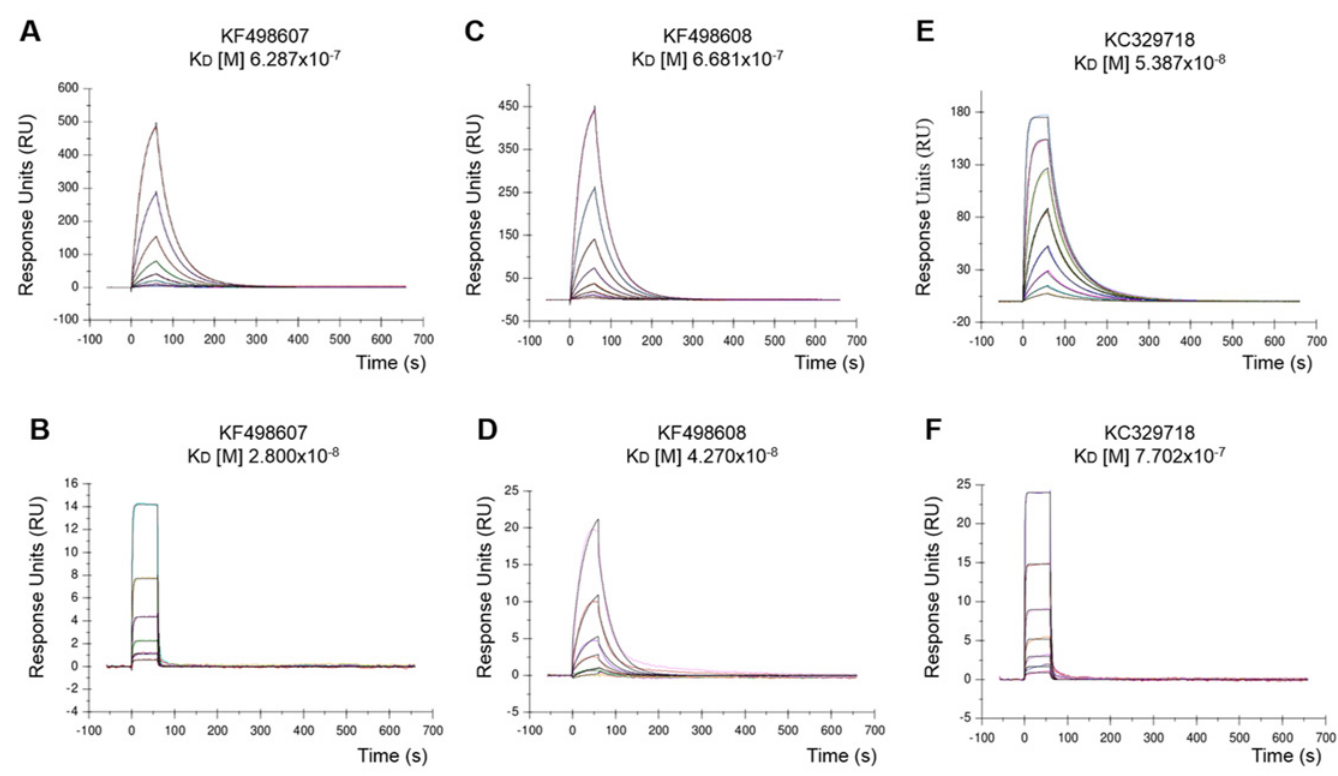
Fig 4. VHHs affinity to BthTX-I and BthTX-II. Representative sensorgrams of the interaction were measured in a Biacore T200 system (GE Healtcare). Purified VHHs (KF498607, KF498608 and KC329718) at concentrations of 6.25 to 0.049 μ g/mL were flowed over a BthTX-I-coated CM5 chip and 25 to 0.006 μ g/mL were used for immobilized BthTX-II. (A) KF498607 x BthTX-I; (B) KF498607 x BthTX-II; (C) KF498608 x BthTX-I; (D) KF498608 x BthTX-II; (E) KC329718 x BthTX-I; (F) KC329718 x BthTX-II. Assays were injected in a flow rate of 30 μ l/min at 37°C. RU indicates resonance